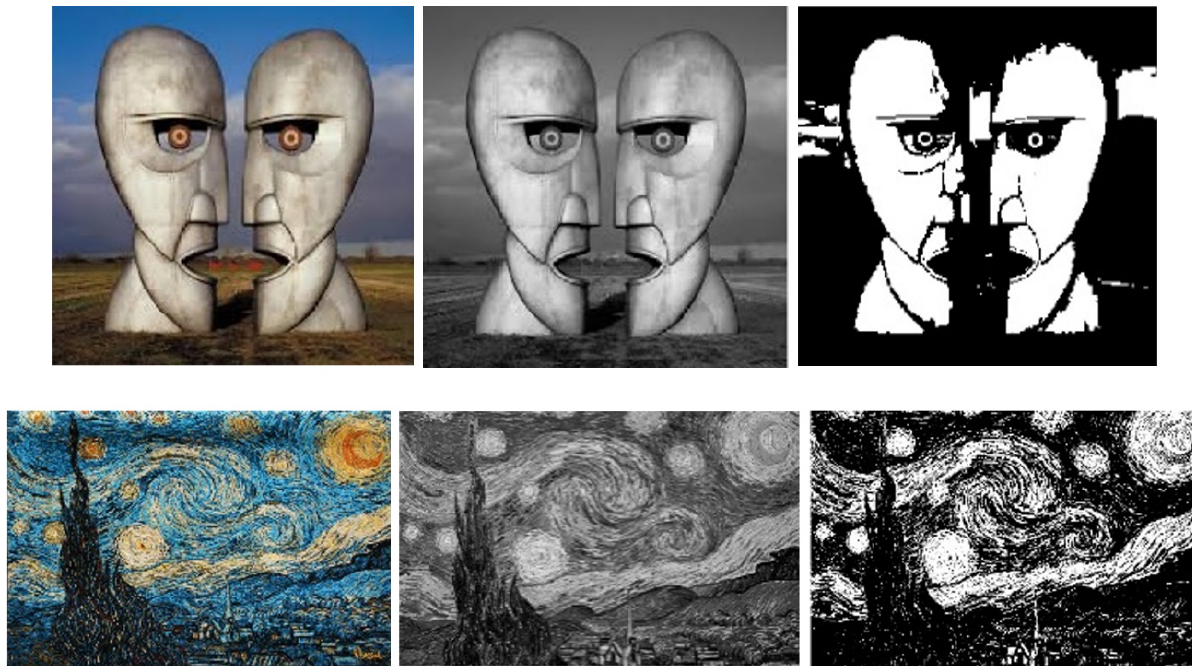
Figure 1. Two digital images repesentations: rgb image (left); grayscale image (center); binary image (right) (Thetapestryhouse.com, n.d.; wikipedia.org, n.d.a)